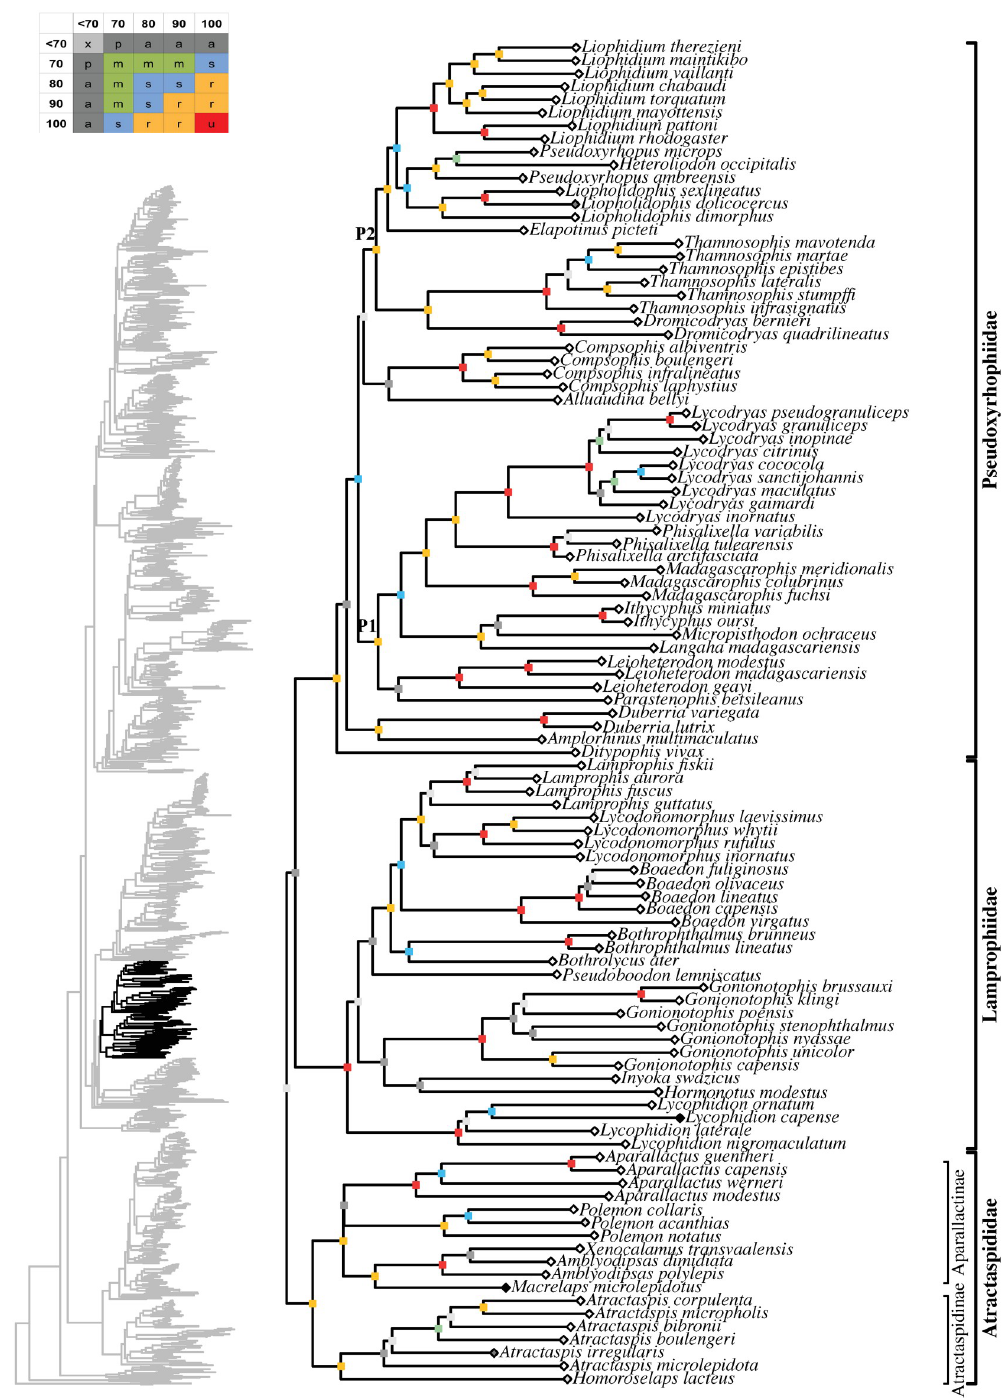
Fig 11. Maximum likelihood species-level phylogeny of Colubroides (continued). Families Atractaspididae, Lamprophiidae, Pseudoxyrhophiidae.